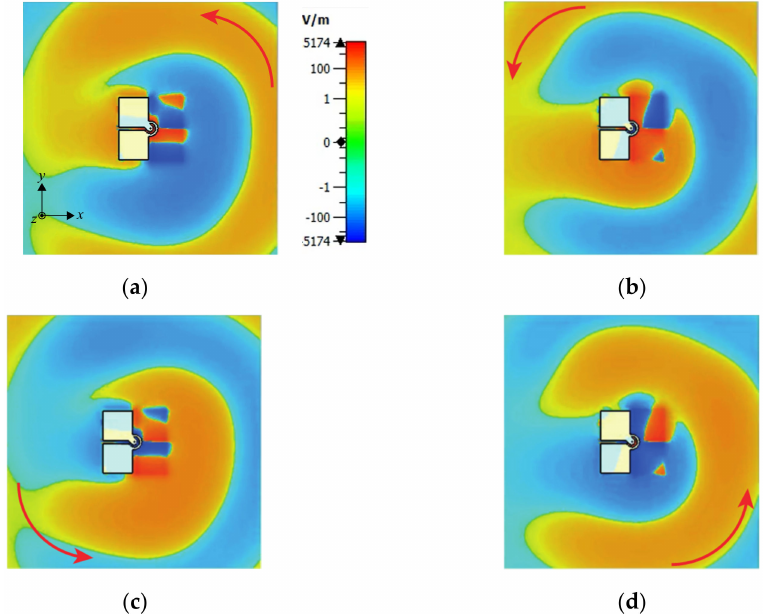
Figure 4. The z-components of E-field of the proposed antenna ( a ) t = T /8; ( b ) t = 3 T /8; in xy -plane; ( c ) t = 5 T /8, ( d ) t = 7 T /8, at 4